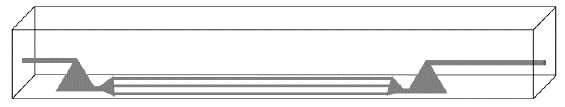
Figure 17. Vascular concept with tubes, accessible from the outside.